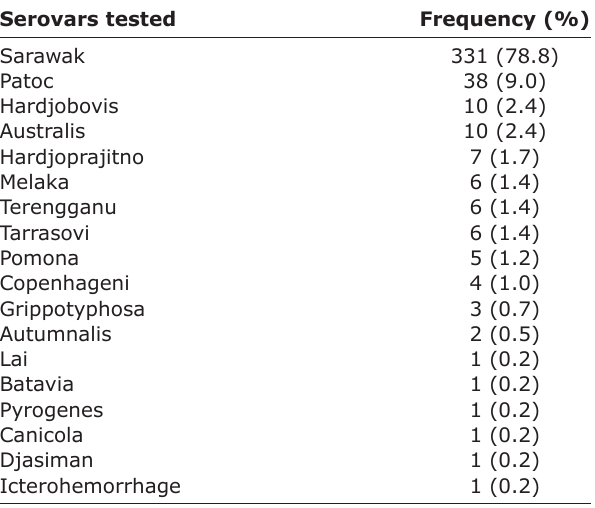
Table-2: Serovar distribution among 343 seropositive cattle determined by positive MAT (titer≥1:100). Serovars